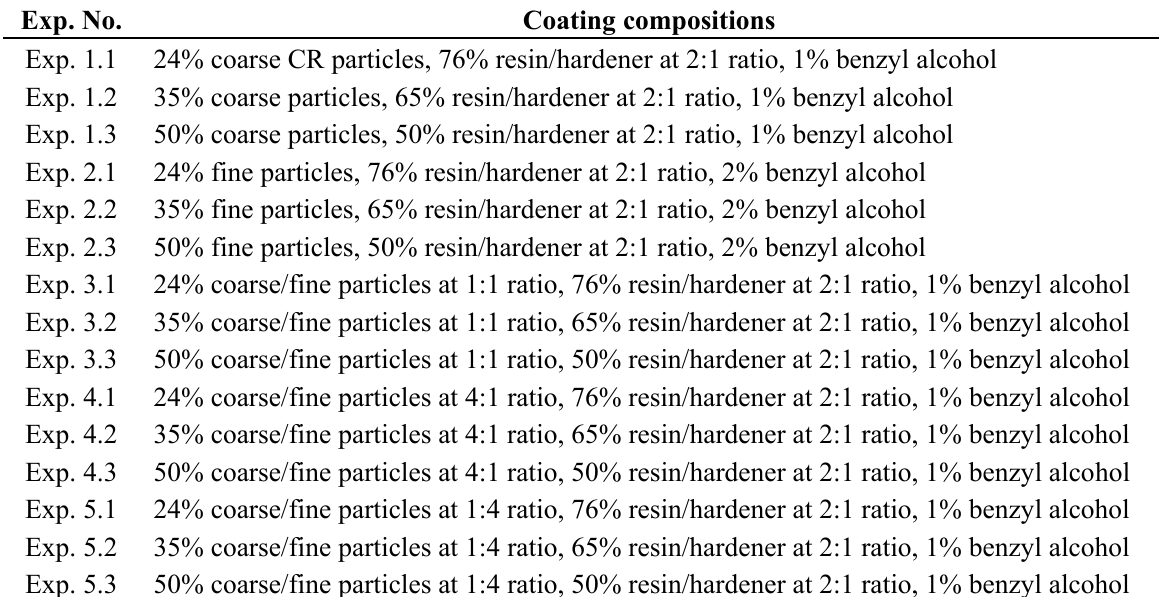
Table 1. Different compositions of the coatings (% benzyl alcohol is relative to the total weight of the coating). Calculation was based on 50 g of